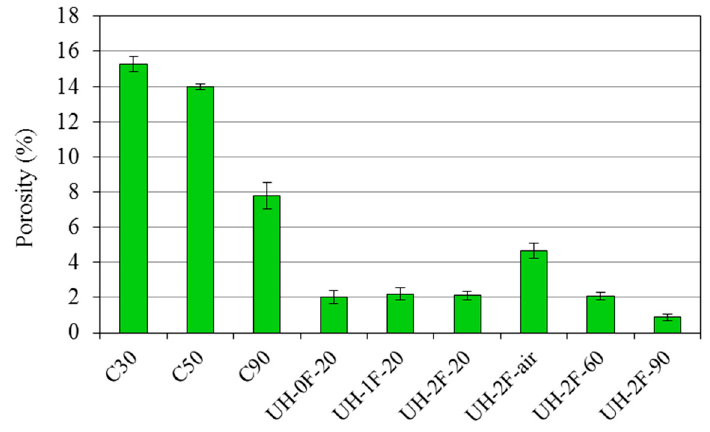
Figure 15. Porosity accessible to